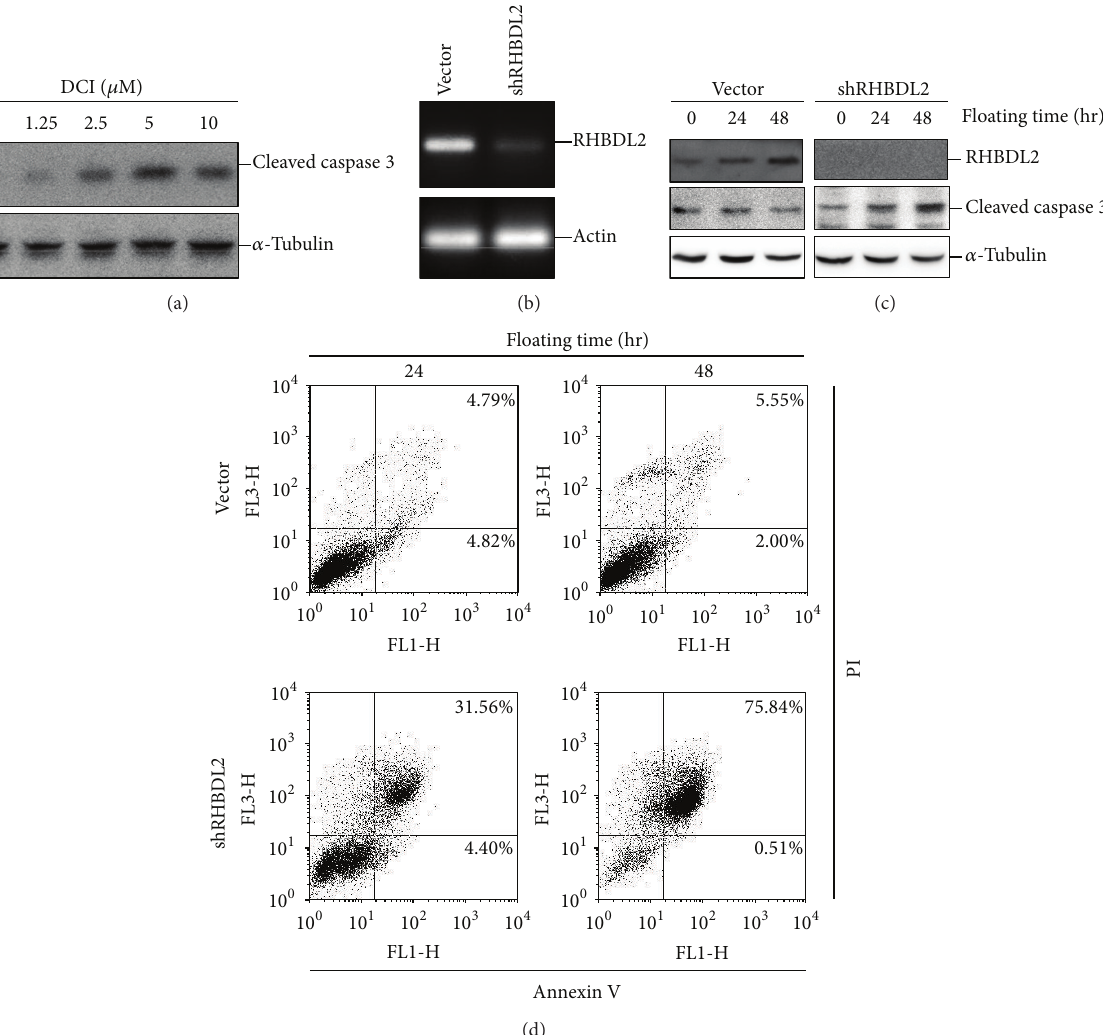
Figure 3: RHBDL2 is essential for anoikis resistance in HeLa S3 cells. (a) Western blot analysis revealed the protein levels of cleaved caspase 3 in suspension-cultured HeLa S3 cells treated with various doses of DCI for 48 hours. (b) Silenced RNA level of RHBDL2 by shRHBDL2 construct was detected by RT-PCR. (c) The protein expression of RHBDL2 and cleaved caspase 3 in shRHBDL2-transfected cells were estimated by Western blotting. (d) Quantification of apoptotic cells under floating culture condition by using Annexin V-FITC/PI